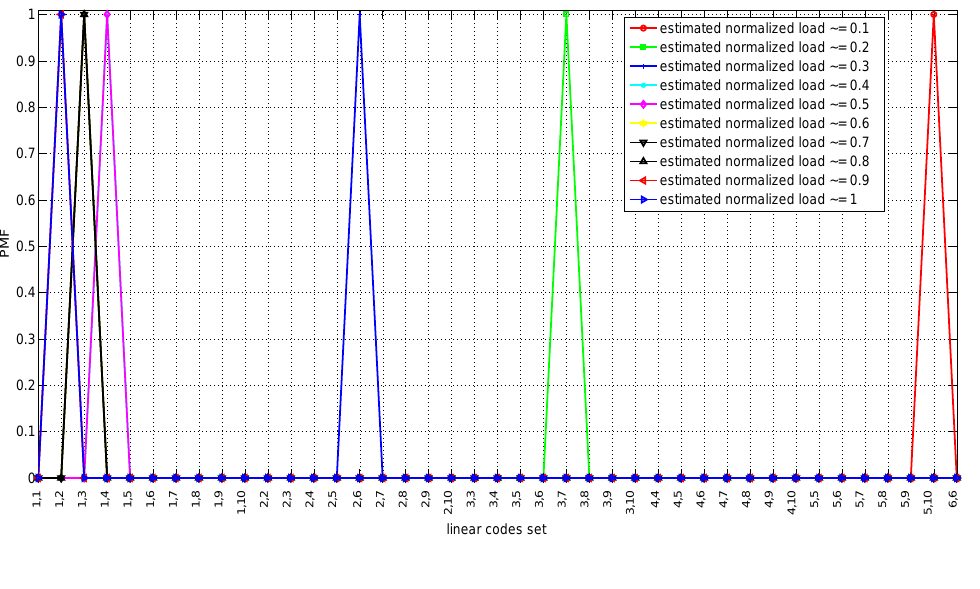
Figure 9. PMF for CE algorithm at different load levels for decreasing G , linear code set C as in table ?? . to 0.1. The P L bounds are shifted up in certain points, according to the algorithm described in section ??